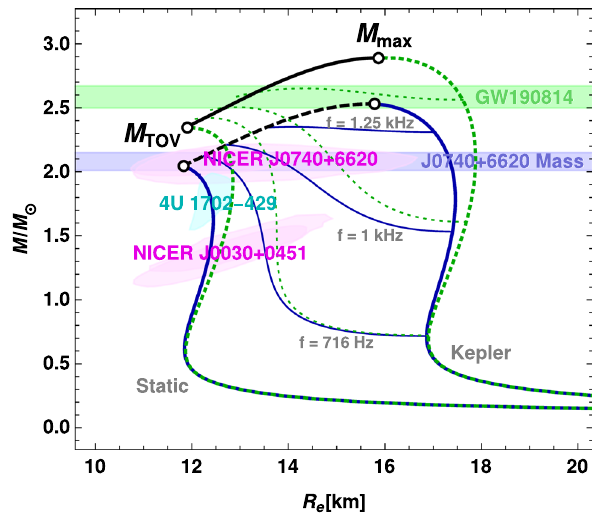
Fig. 18 Tidal deformability for the V-QCD(APR) hybrid EOSs, as a function of the neutron star mass, compared to the LIGO/Virgo result for the tidal deformability Λ 1 . 4 at M = 1 . 4 M (cid:3)